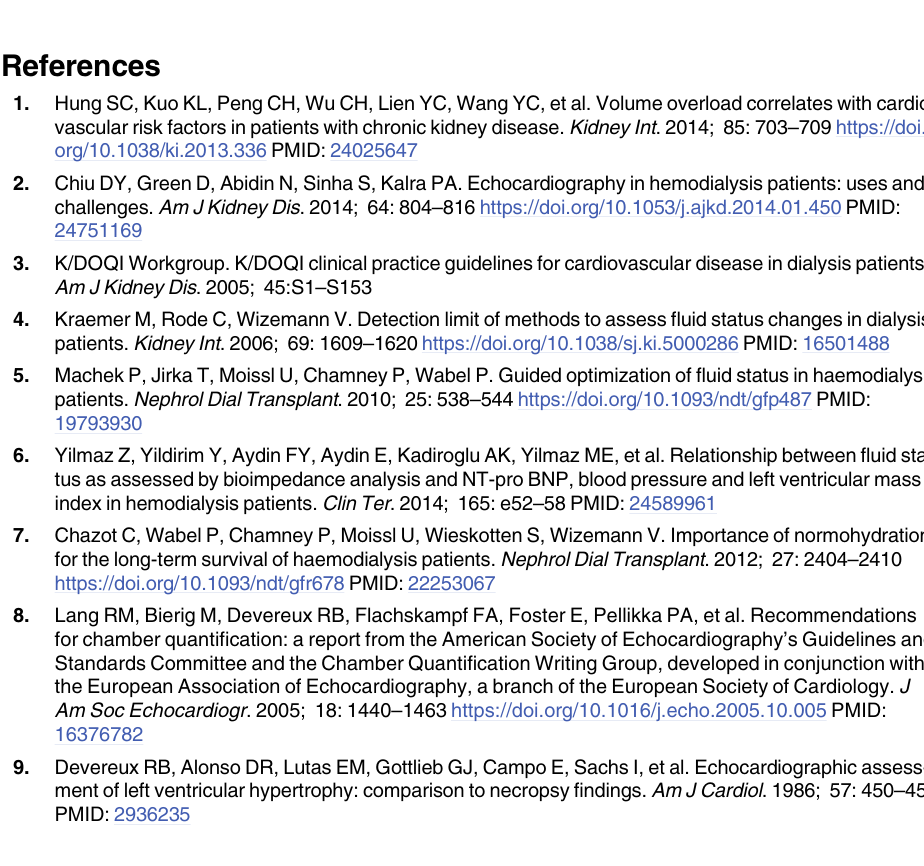
S1 Table. Correlation of OH and OH/ECW with serum laboratory